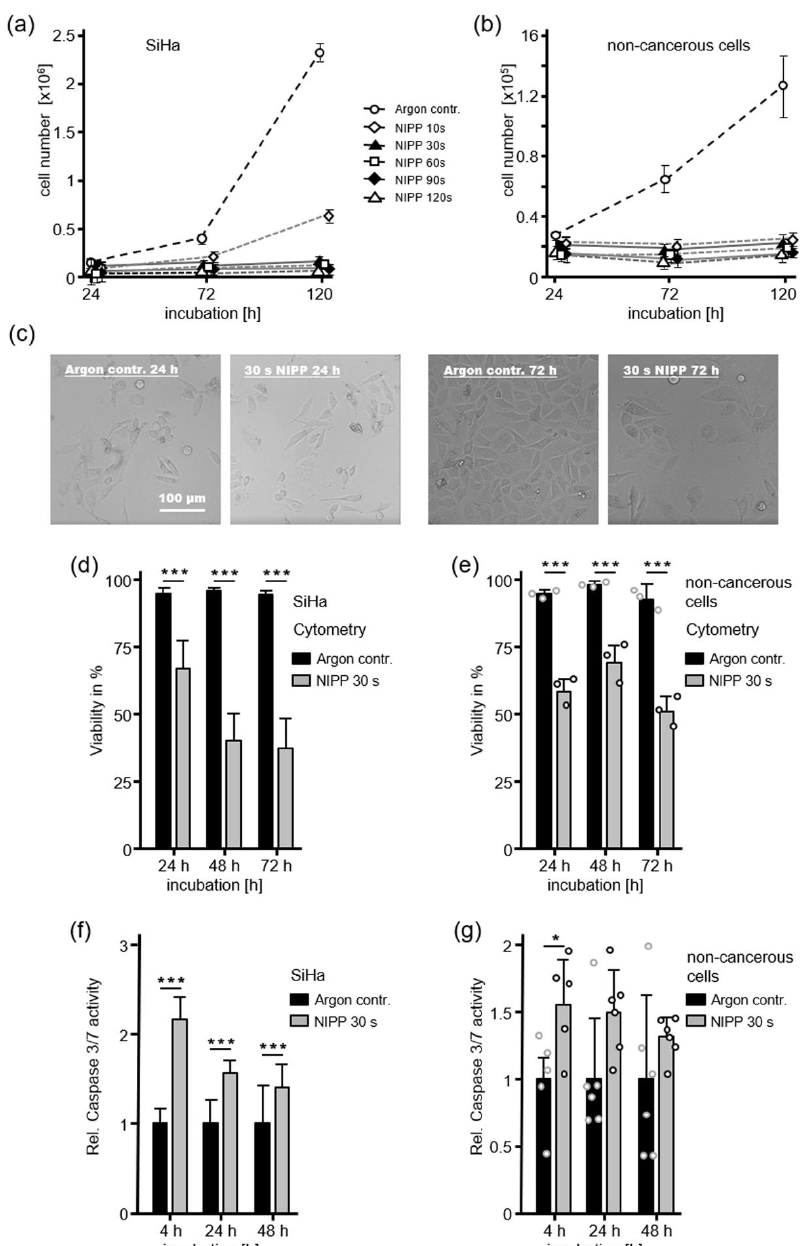
Figure 1. Non-invasive physical plasma (NIPP) has antiproliferative and cytotoxic effects on cervical cancer (CC) cells and primary cells from healthy cervical tissue. ( a , b ) After treatment with different doses of NIPP or argon gas, cell numbers dose-dependently decreased after 24, 72 and 120 h. ( c ) Surviving CC cells showed altered cell morphology after NIPP treatment. ( d , e ) In both cell types, NIPP-induced cytotoxicity was determined by staining with Guava ViaCount Reagent and subsequent flow cytometry. ( f , g ) Caspase-Glo 3/7 assay indicated apoptotic cell death induced by NIPP. This e ff ect was higher on CC cells compared to cells from healthy cervical tissue. The results are expressed as the mean ± SD of at least three independent experiments. For non-cancerous cells, each independent experiment was performed with cells from a di ff erent donor. * p < 0.05 and *** p < 0.001, as determined by Student’s t